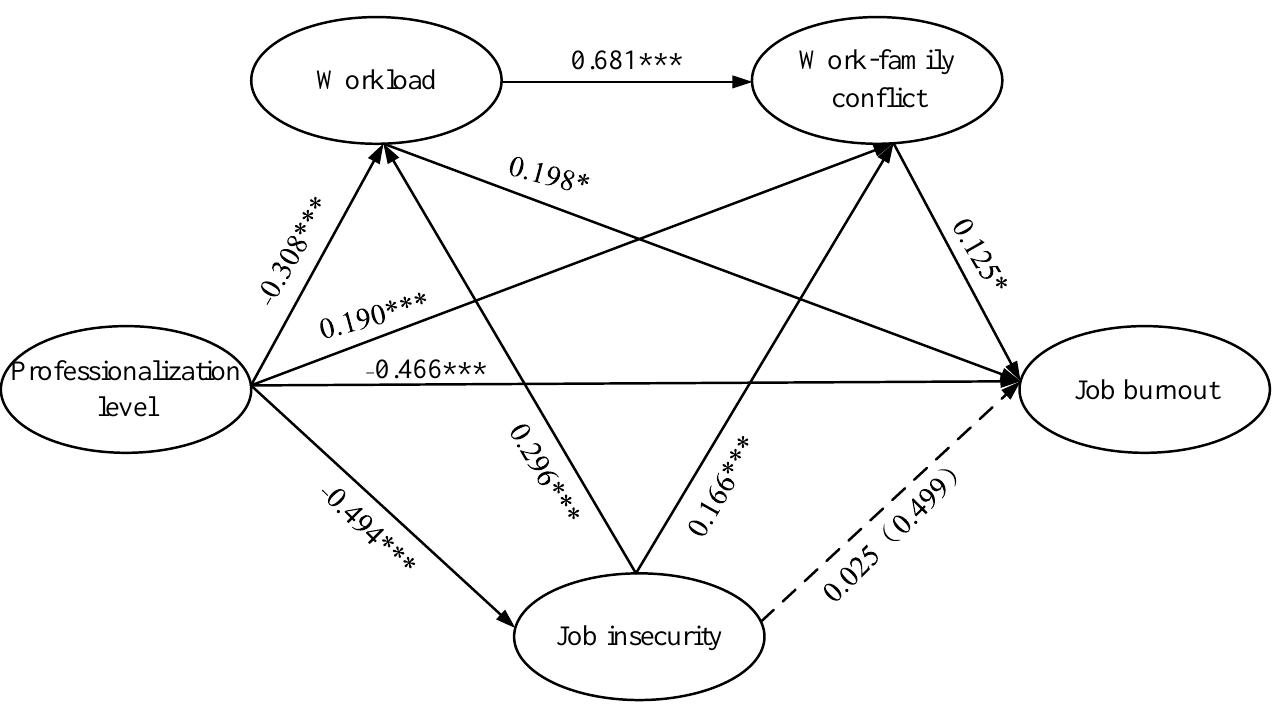
Figure 2. Research model and results of the hypothesis test. Note: the values on the lines are the path coefficients. The value in brackets is p . The solid lines and dashed lines indicate passed paths and rejected paths, respectively. ***, p < 0.001; *, p < 0.05. Table 5. Hypothesis testing results.